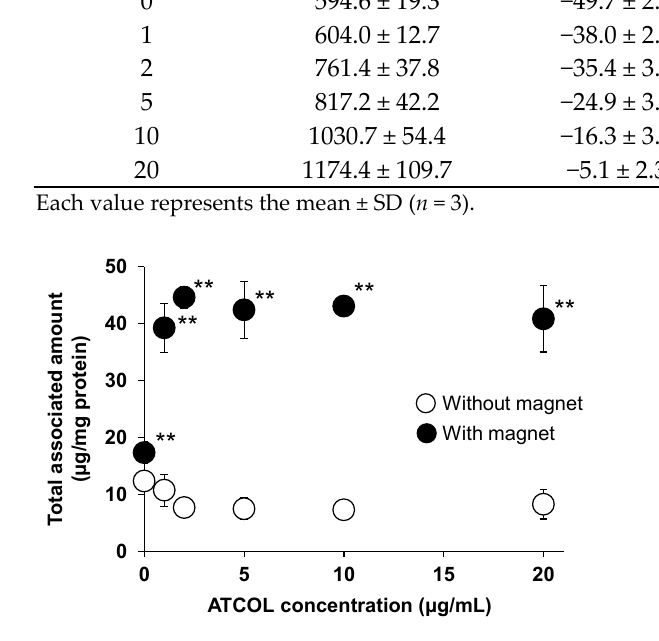
Figure 1. Effect of ATCOL concentrations on the cellular association and/or uptake of large-sized Mag-AL/ATCOL complexes. The complexes with a fixed concentration of large-sized Mag-AL (10 µg/mL) were added to each well and incubated for 30 min at 37 °C in the presence or absence of a magnetic field. Each value represents the mean ± SD ( n = 4). ** p < 0.01, compared with the absence of a magnetic